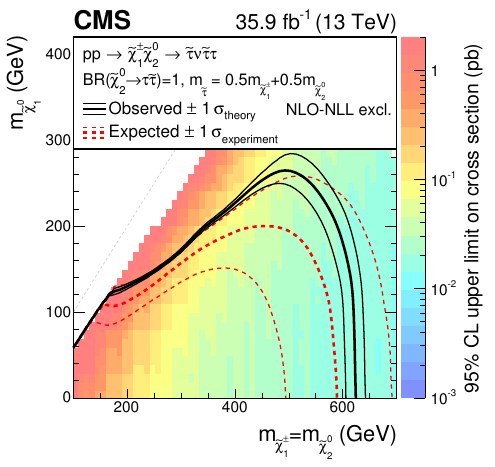
Figure 17 . Interpretation of the results in the (cid:28) -dominated model with mass parameter x = 0 : 5 obtained with events of category B{F. The shading in this (cid:12)gure is as described in (cid:12)gure 14.